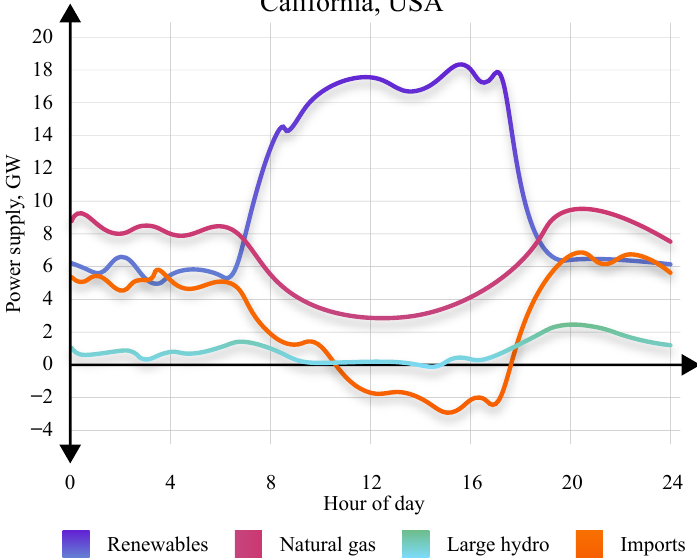
Figure 18. California’s daily power consumption curve shows sharp increase for RES during sunlit hours, indicating solar energy playing a significant role in the energy mix